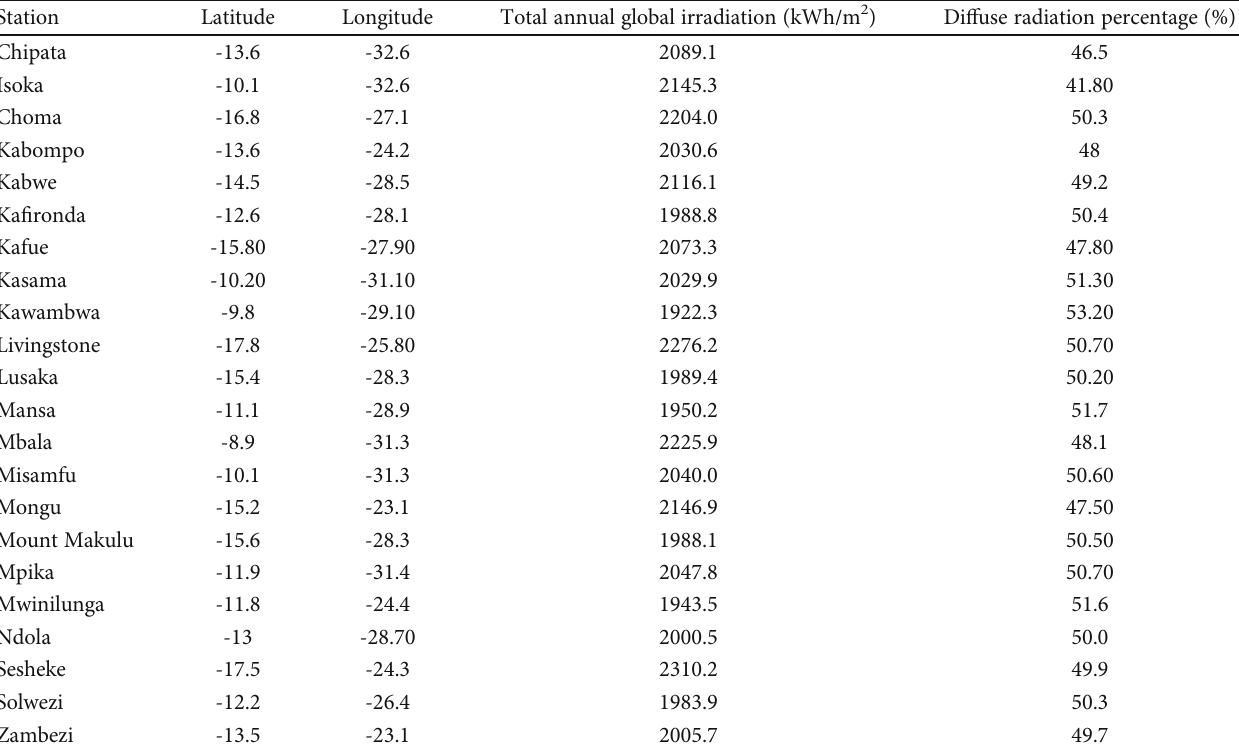
Table 2: The data of the studied